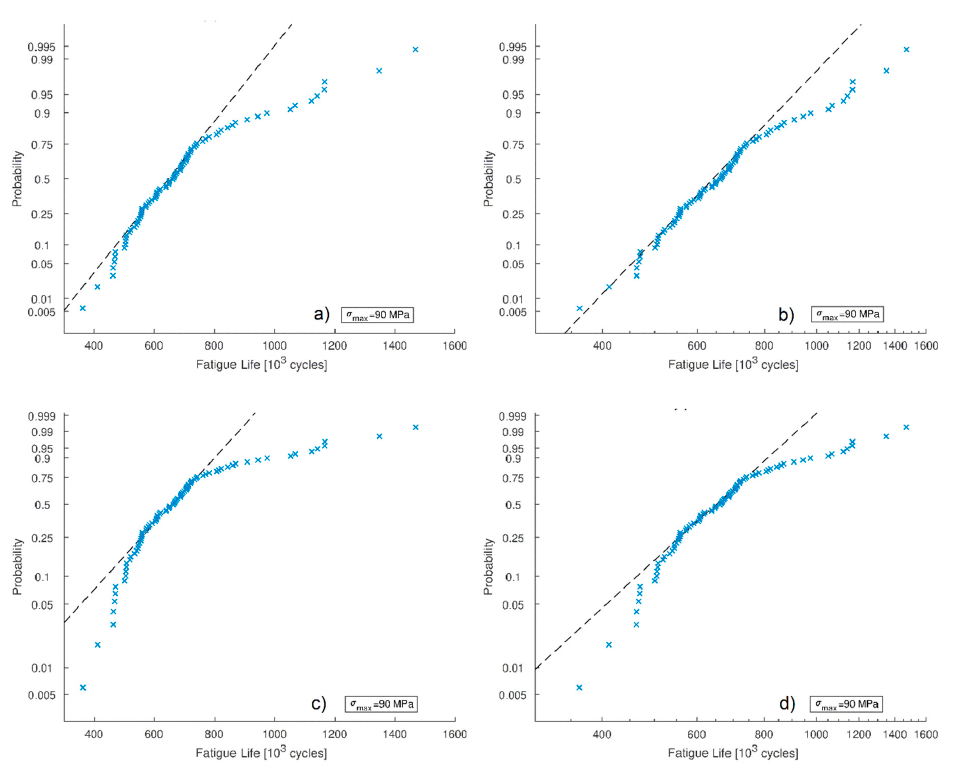
Figure 8. Fatigue life at 90 MPa: probability plots for normal ( a ), log-normal ( b ), extreme value ( c ) and Weibull ( d ) distributions.